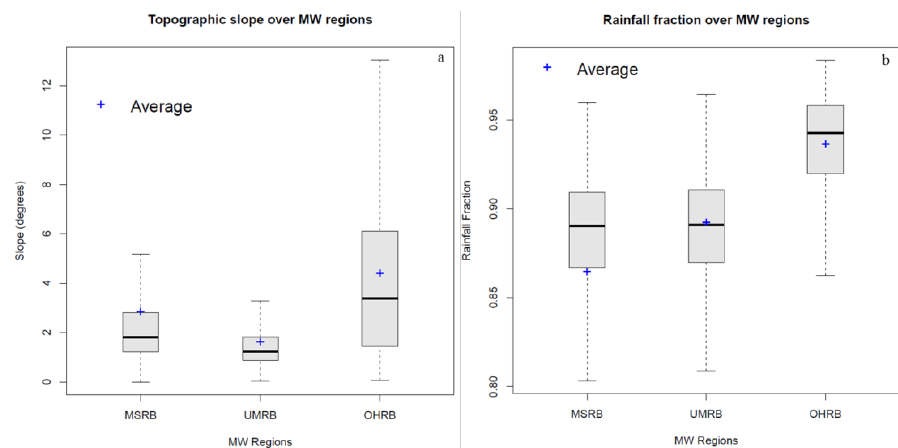
Figure 12. Topographic slope and rainfall fraction over the Missouri, Upper Mississippi and Ohio